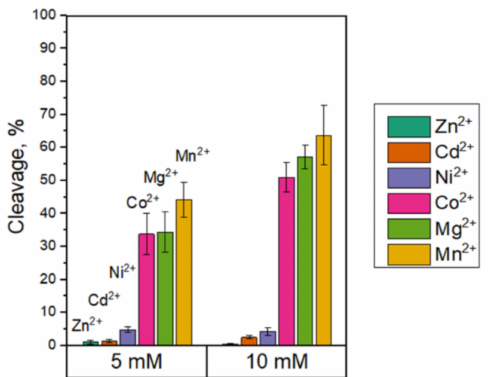
Figure 2. The influence of different divalent cations (at 5 or 10 mM) on the nicking activity of Nt.BspD6I. The nicking was not detectable in the presence of calcium